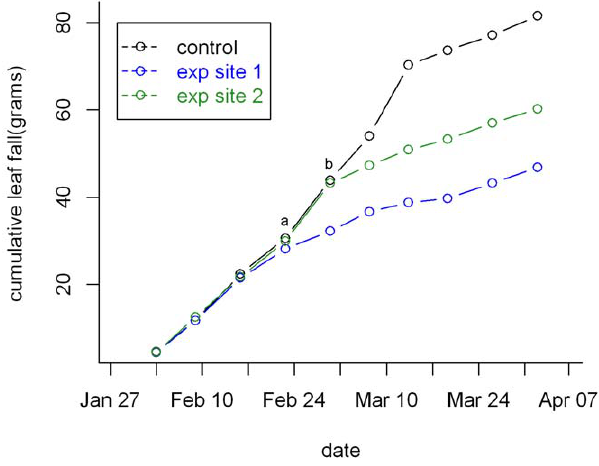
Figure 3. Cumulative leaf fall on control and irrigation plots. Leaves were collected weakly in 0.5 m 2 traps and values have been scaled to grams/m 2 . a and b represent the onset of irrigation for experimental sites 1 and 2